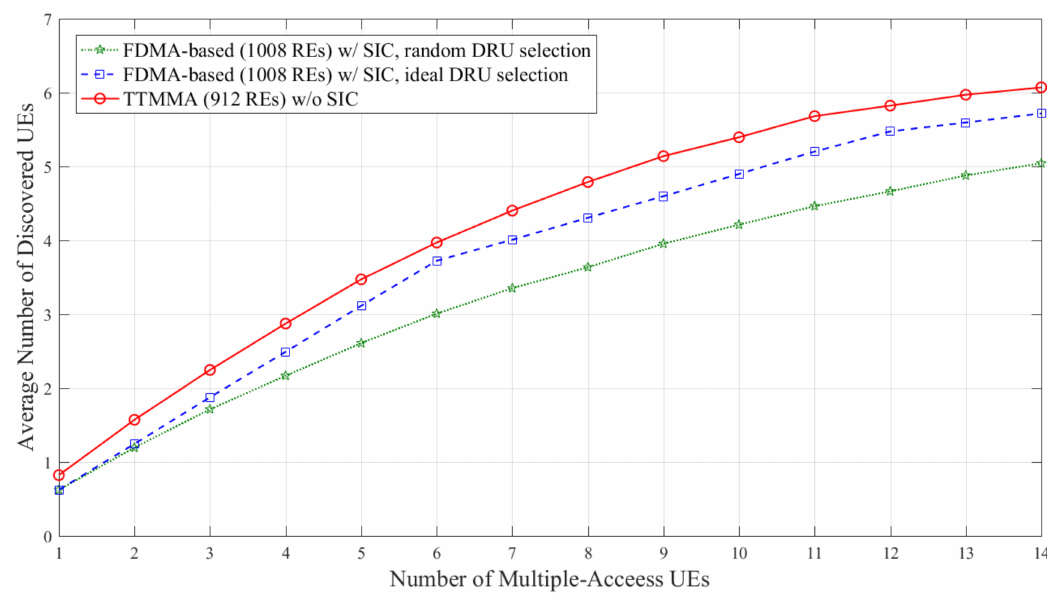
Figure 8. Average number of discovered UEs according to the number of multiple-access UEs in block Rayleigh fading channel, only applying SIC to the frequency division multiple-access (FDMA)-based scheme.